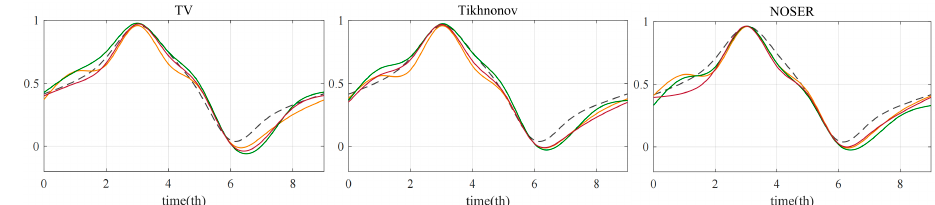
Figure 12. Reconstruction curve of pixel values in cardiac region under each algorithm.